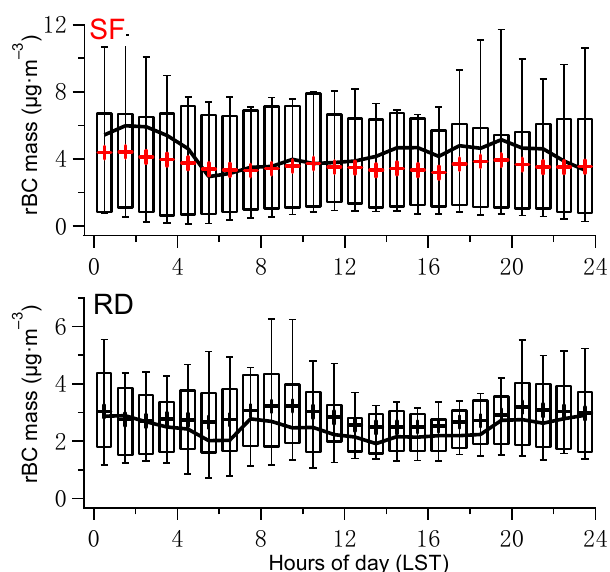
Figure 3. Mean diurnal variation patterns of rBC concentrations for spring festival and regular day (The upper and lower edges of the box denote the 25% and 75% percentiles, respectively. The lines in the middle of the box and cross markers indicate the median and average values respectively, with error bars explaining the 10% and 90% percentiles.).